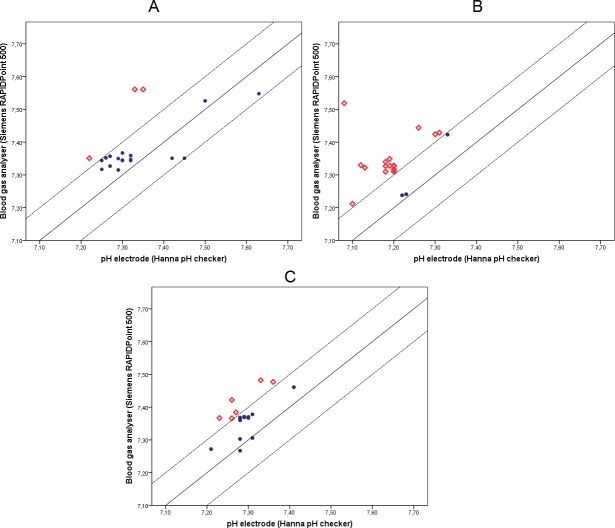
Closeness of agreement between pH electrode and blood gas analyzer (trueness).(●) Measurements that are within predefined allowable total error of 0.1 pH unit. (◊) Measurements that are outside predefined allowable total error of 0.1 pH unit in the three tested media. A: medium 1, B: medium 2, C: medium 3.